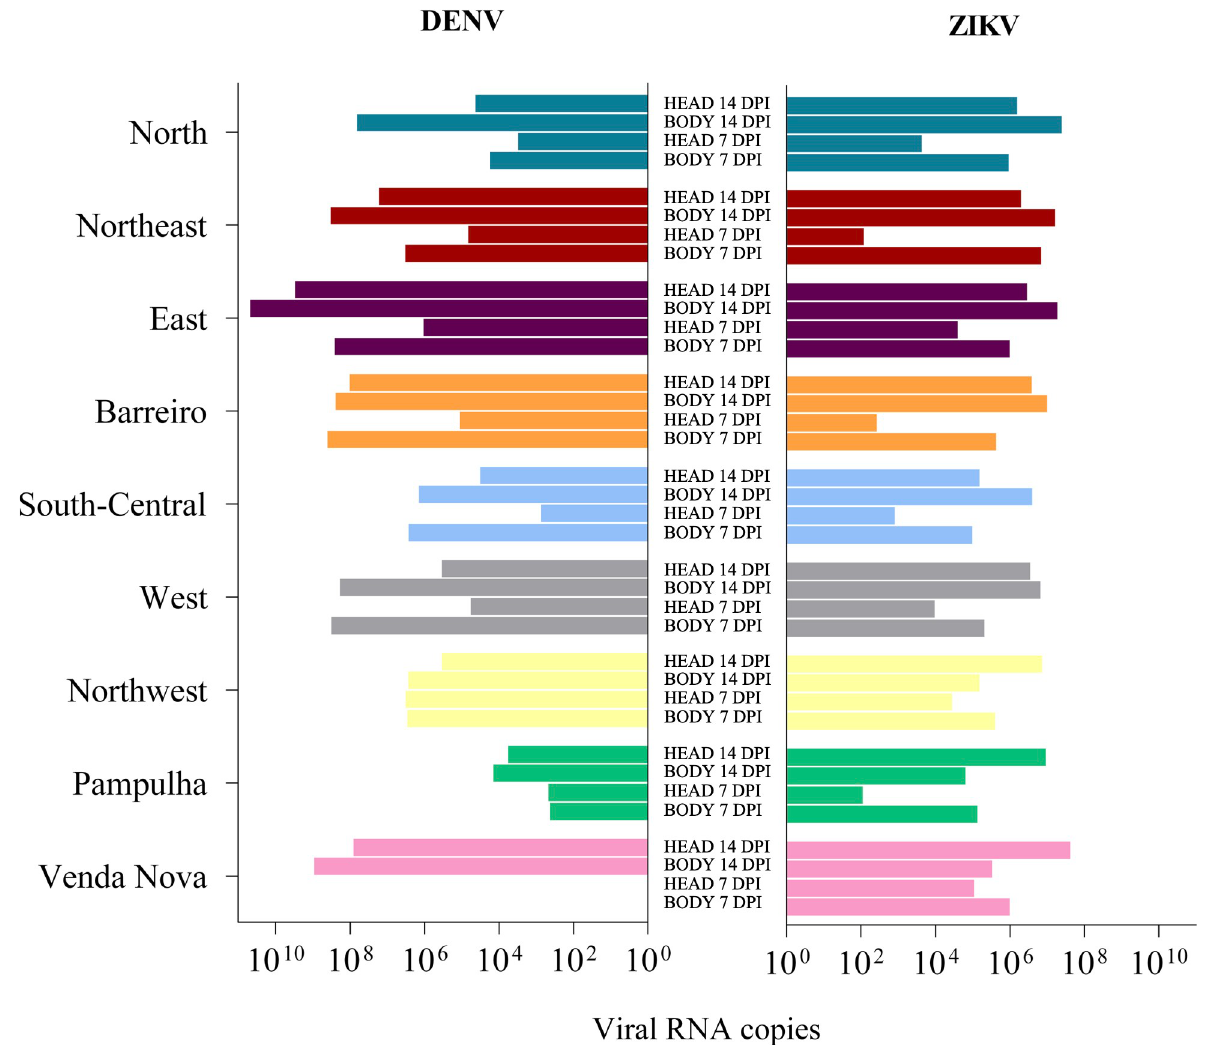
Fig 5. Comparison of the pattern of viral load sets for each population, previously described in Figs 3 and 4, between DENV and ZIKV in the body and head/salivary gland (SG) at 7 and 14 days post-infection (dpi). The bars represent the viral load medians, and were disposed in a model that highlight the specific patterns of each